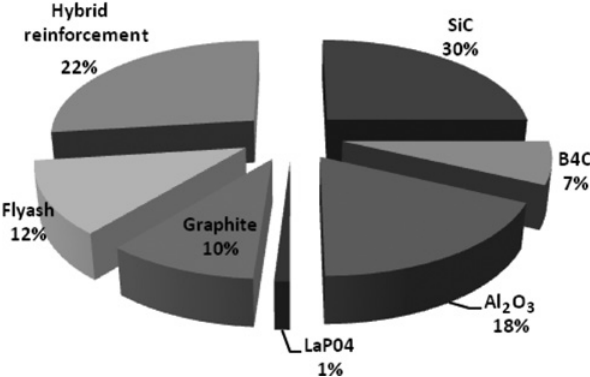
Figure 8: % Contribution of research on reinforcements.